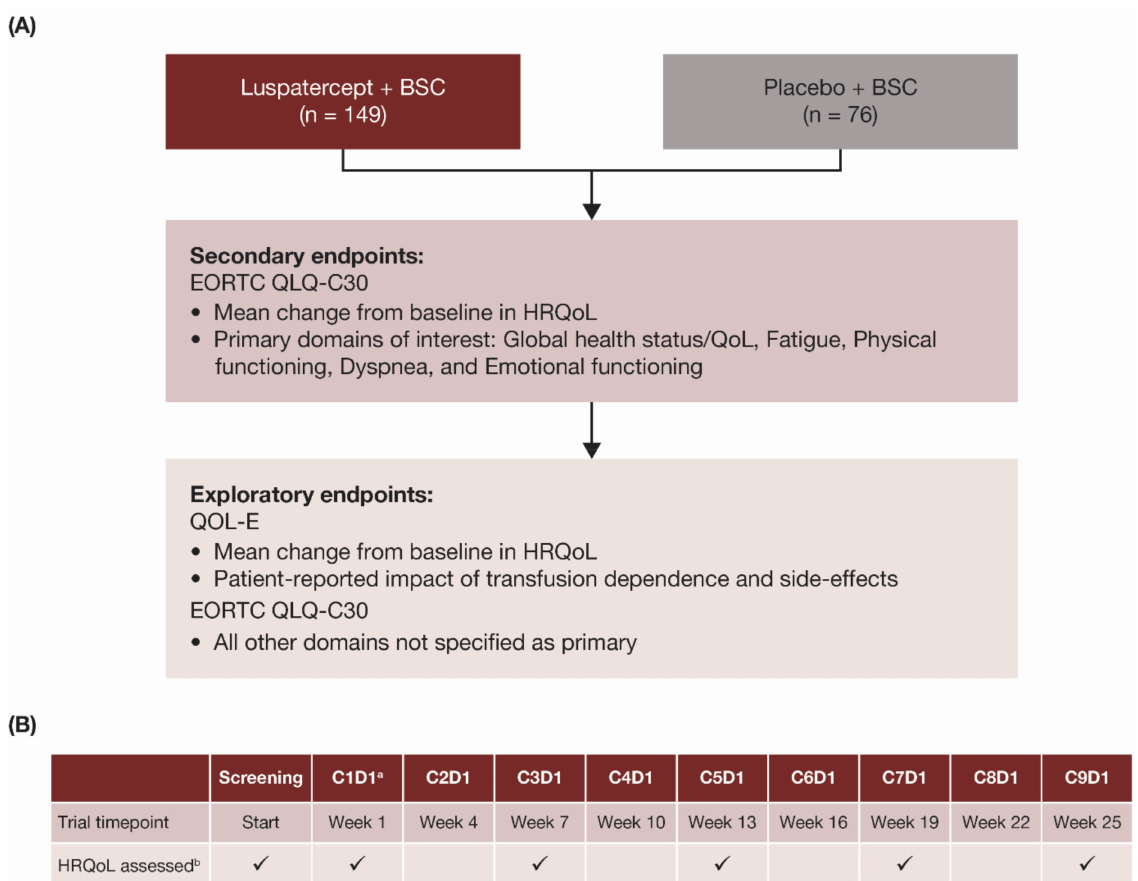
Figure 1. ( A ) Endpoints and ( B ) assessment schedule for patient-reported HRQoL outcomes in the MEDALIST trial. a Baseline visit. b HRQoL assessed with EORTC QLQ-C30 and QOL-E instruments on days indicated with checkmark (